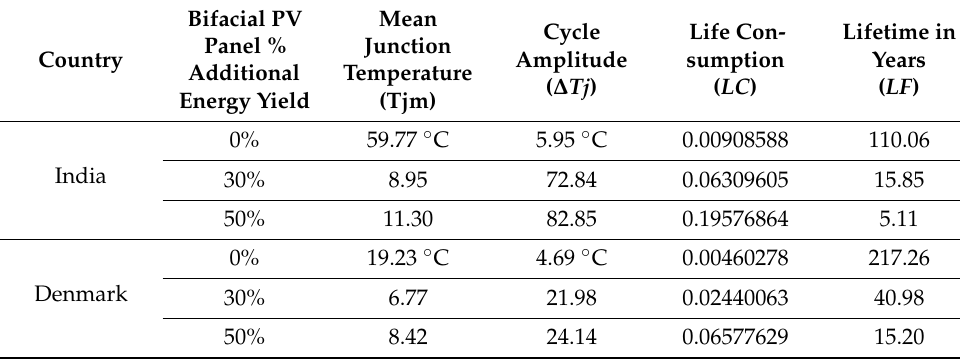
Table 5. Lifetime Evaluation considering Bifacial PV panel.